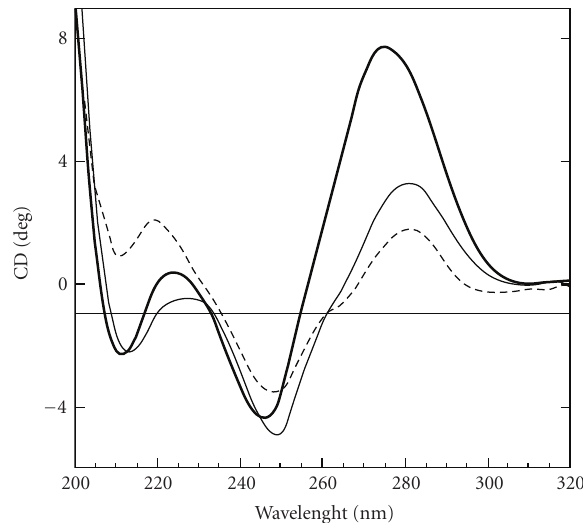
Figure 6: CD spectra of TFOs bound to duplex DNA. Shown are spectra for target DNA duplex alone (dashed line) or duplex incubated with TFO DNA-C2 (thin line) or TFO RNA-C2 (bold